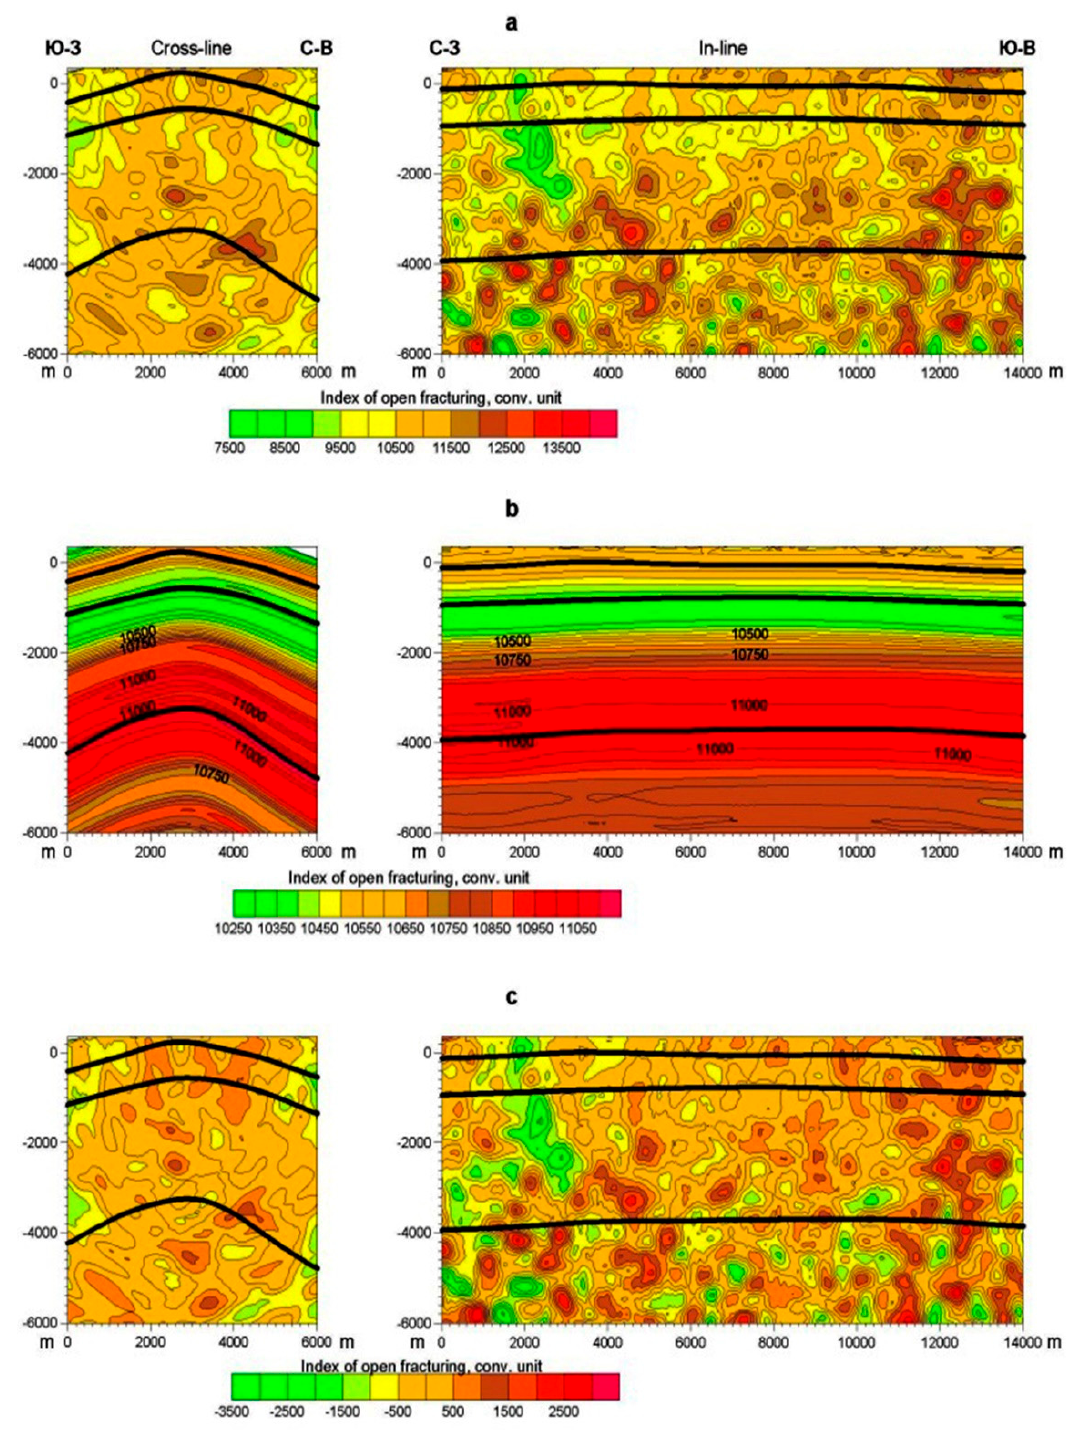
Figure 7. The SVSL results for the study area. ( a ) The seismic sections are averaged over horizontal planes of the source cube; ( b ) The seismic sections are averaged over lateral surfaces; ( c ) presents a difference of these two matrices: a–b. Distribution of the fractures has changed insignificantly, an indication of the fact that the tectonic factors (highly various fracturing intensity and fractured zones locations) are the major reason behind random distribution of fractures. A major fracture system was formed during formation of the anticlinal fold which is characterized by a V-shaped complex of linear zones orthogonal to the fold flanks and a local anomaly in the fold arch.